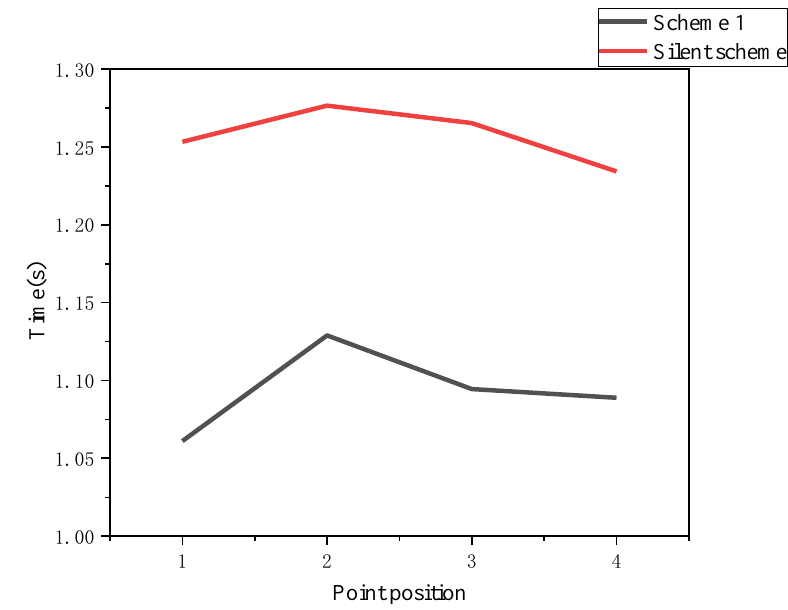
Figure 16. Time comparison between scheme 1 and the non-tactile scheme.